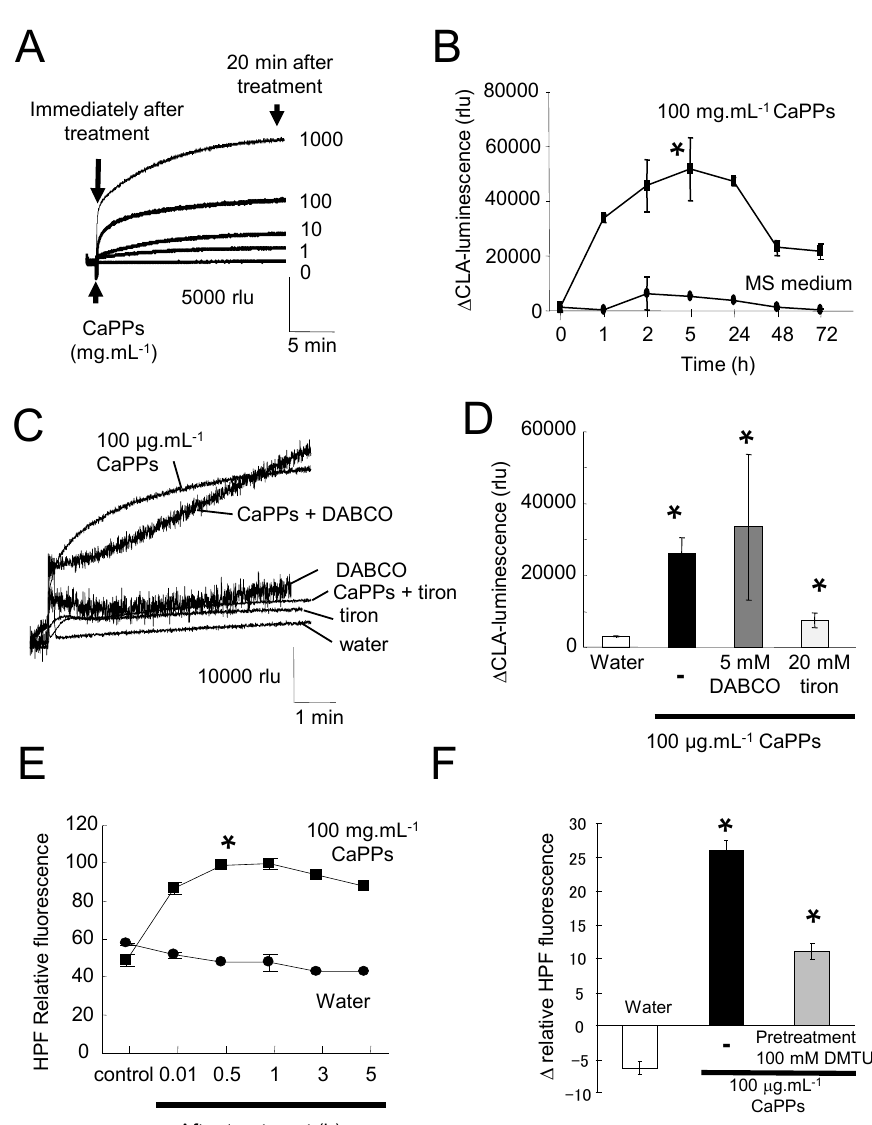
Figure 1. Calcite processed particles (CaPPs)-induced ROS generation in free Murashige and Skoog